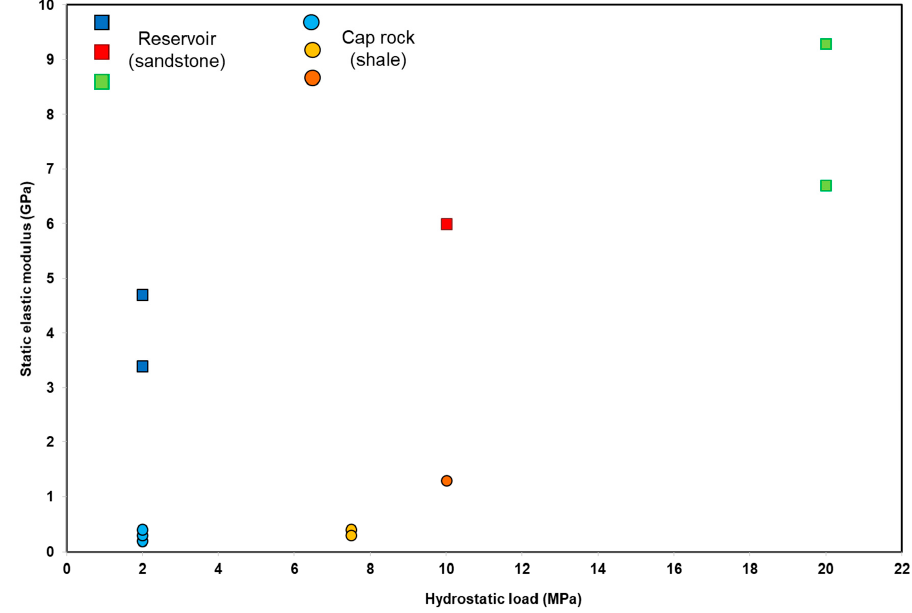
Figure 6. Lab test results: static elastic moduli values in relation to confined pressure.